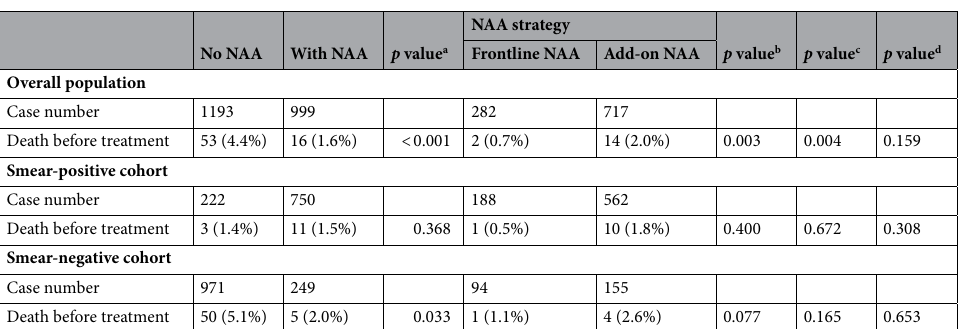
Table 3. Death before anti-TB treatment among pulmonary TB patients with and without NAA test. Data are presented as n (%). NAA nucleic acid amplification, TB tuberculosis. a Comparison between patients with and without NAA tests. b Comparison between patients with frontline NAA and no NAA test. c Comparison between patients with add-on NAA and no NAA test. d Comparison between patients with frontline and add-on NAA test.